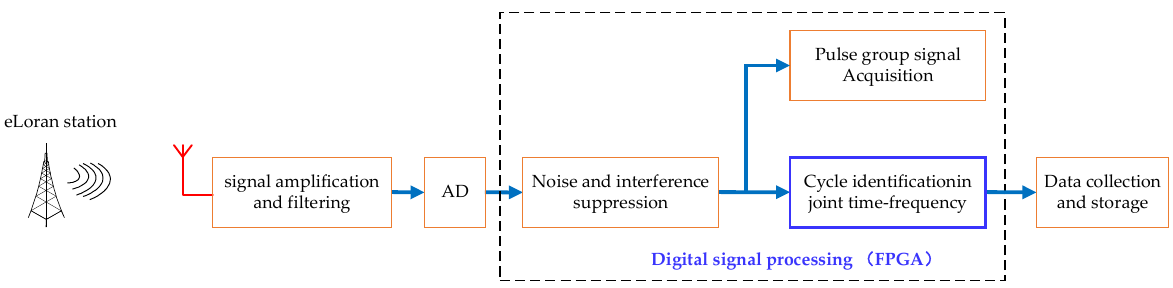
Figure 10. Test scheme of cycle identification method.